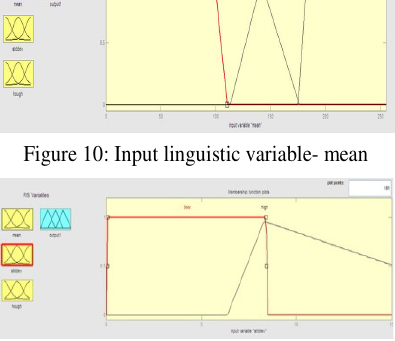
Figure 11: Input linguistic variable- standard deviation